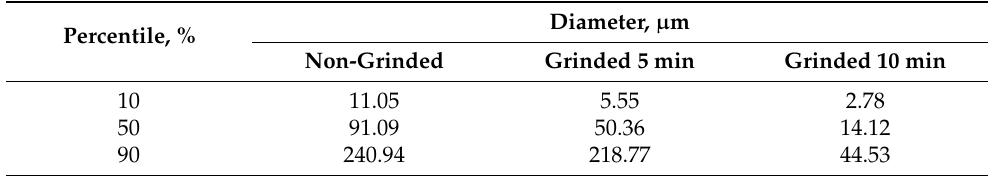
Table 3. Average percentage particle size distribution.